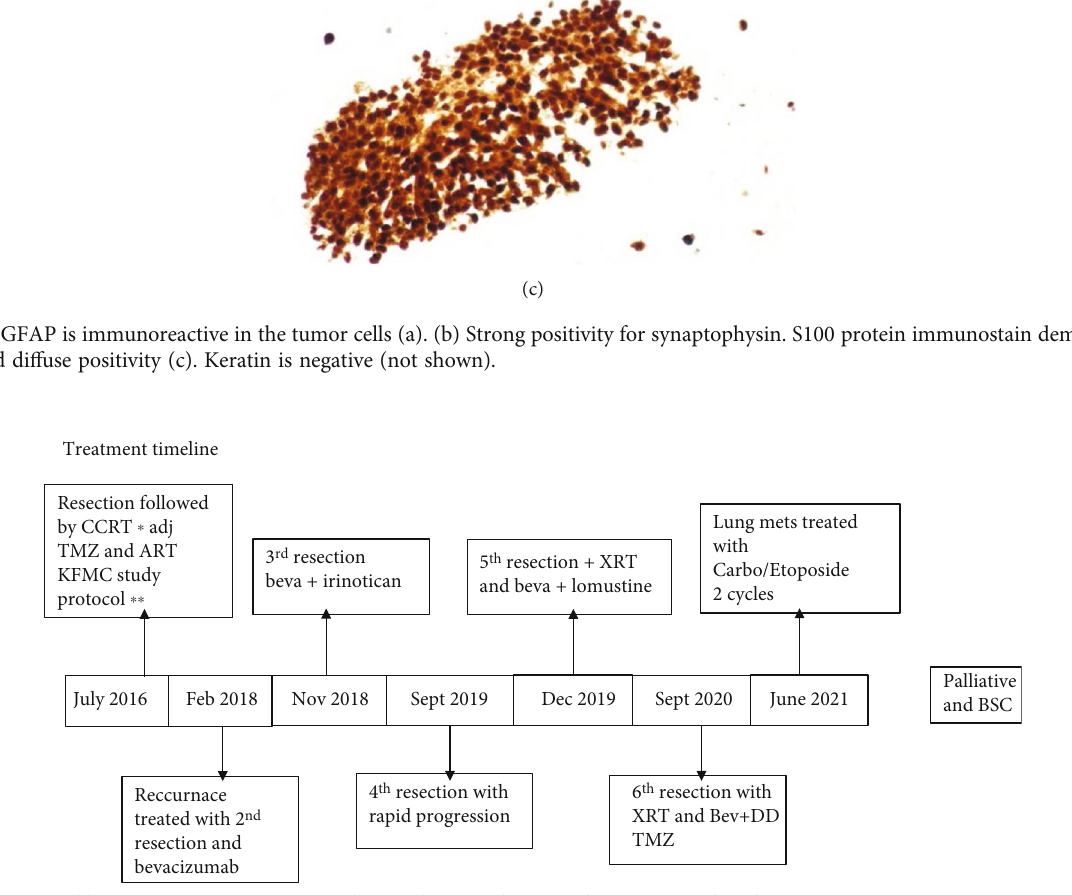
Figure 5: Treatment timeline. Abbreviations: CCRT: concurrent chemoradiation; Adj TMZ: adjuvant temozolomide; XRT: radiation therapy; DD: dose